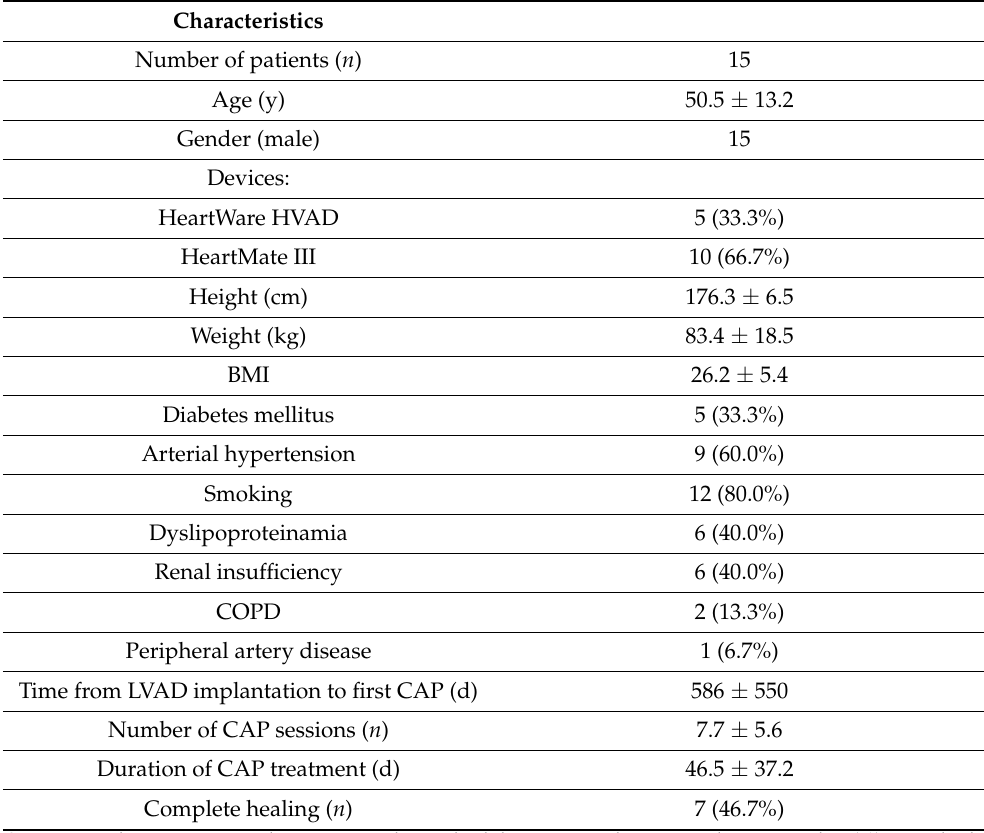
Table 1. Patient